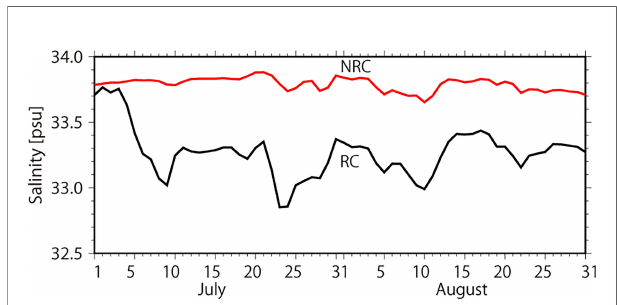
FIGURE 9 | Temporal variation in the calculated sea surface salinity at the Hayasui Strait in the northern Bungo Channel from July 1 to August 31. Black and red lines show the variation in the rain (RC) and no-rain (NRC) cases, respectively.